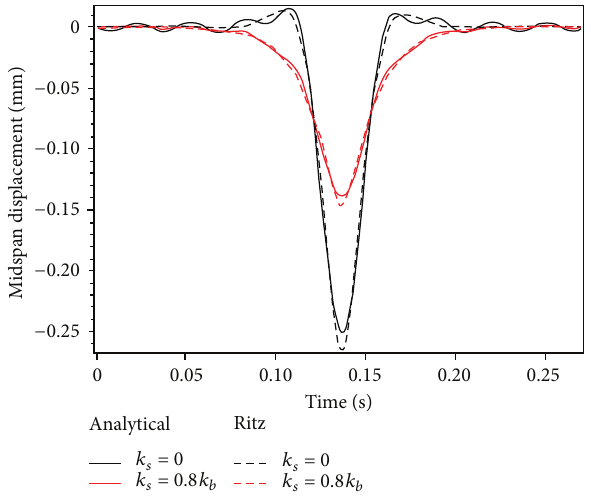
Figure 3: Comparison of analytical and Rayleigh-Ritz